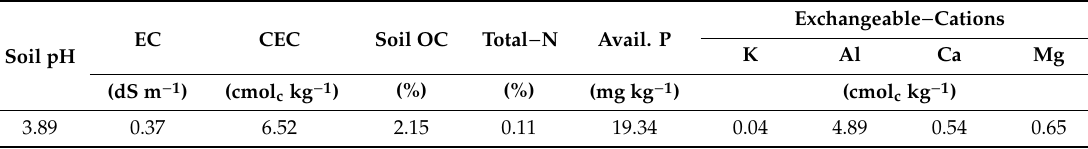
Table 2. Chemical characteristics of the soil in the experimental plots.